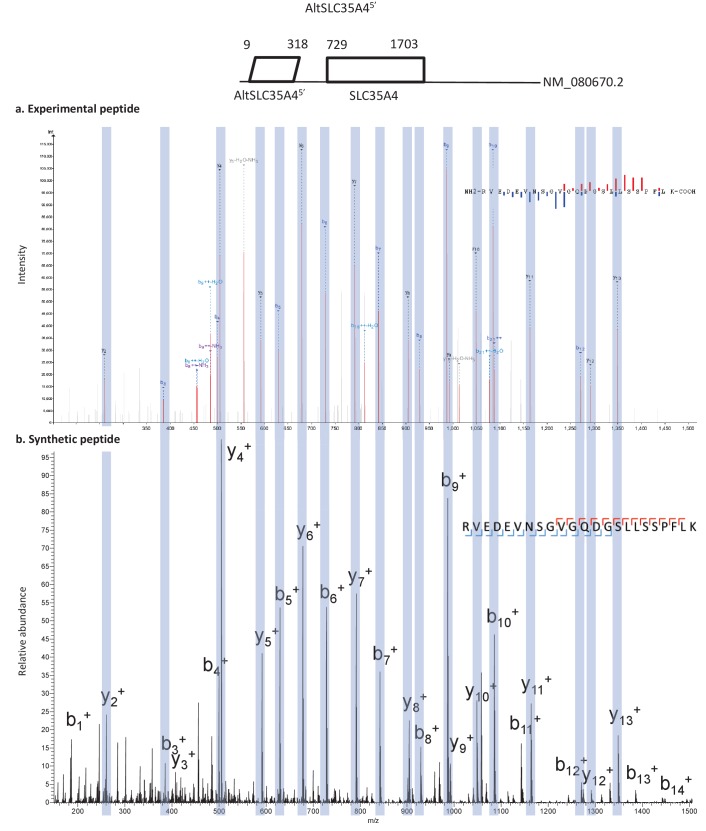
Spectra validation for altSLC35A45’.Example of validation for altSLC35A45’ specific peptide RVEDEVNSGVGQDGSLLSSPFLK. (a) Experimental MS/MS spectra (PeptideShaker graphic interface output). (b) MS/MS spectra of the synthetic peptide. Matching peaks are shown with blue masks. A diagram of the transcript with its accession number and the localization of the altORF and the CDS is shown at the top.